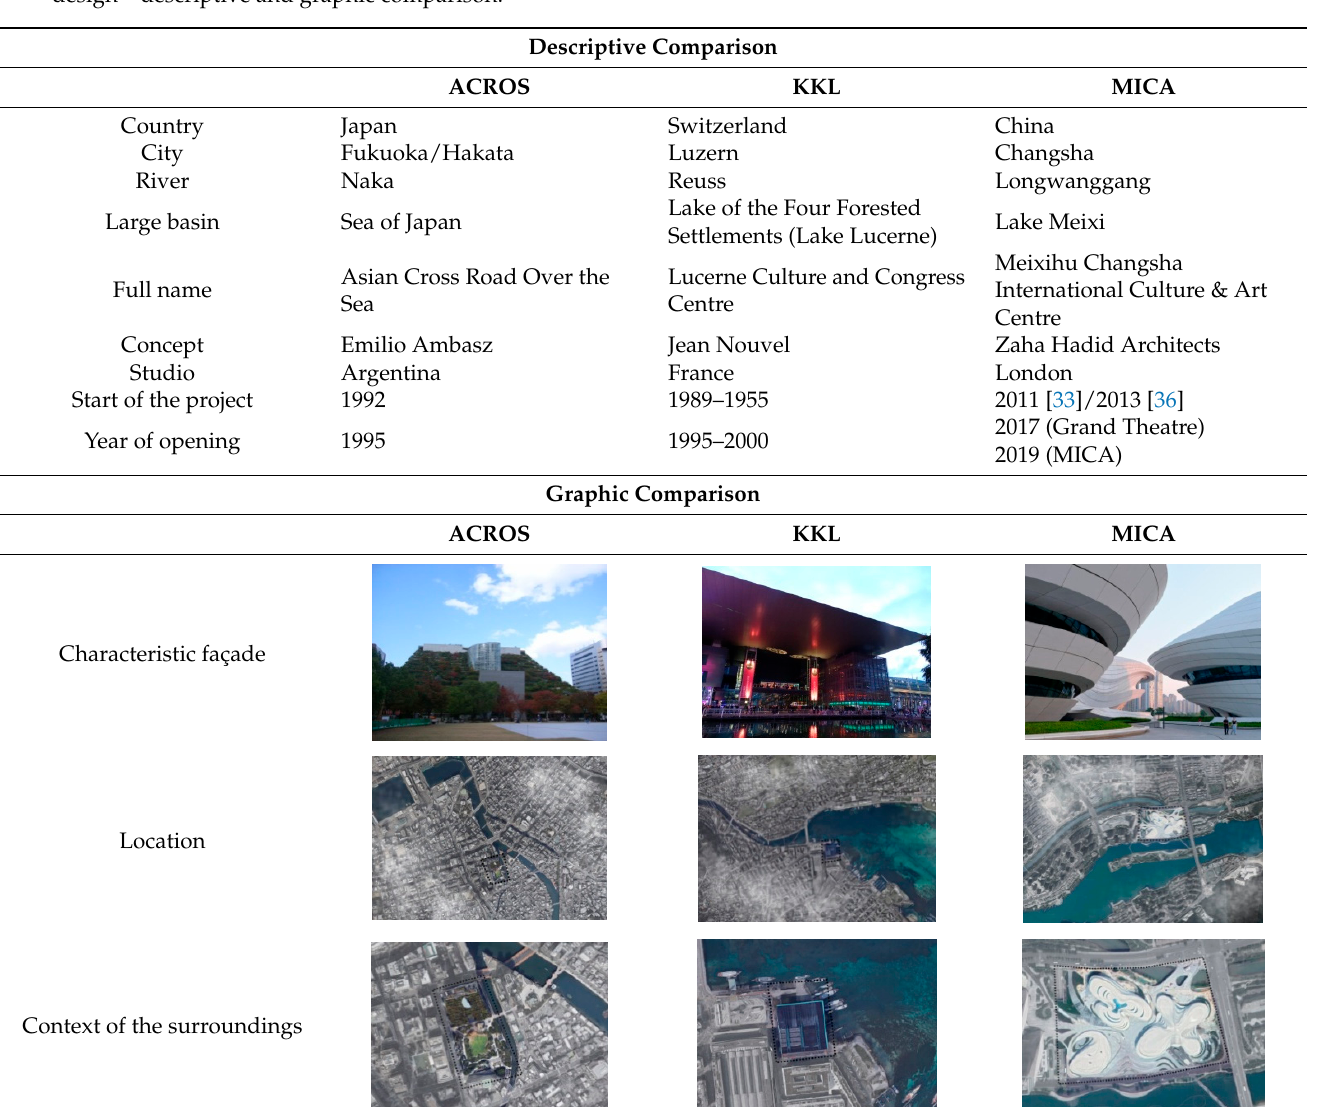
Table 1. Comparison of the bodies of investigated objects: Prefectural International Hall “Asian Cross Road Over the Sea”—ARCOS Fukuoka, Kultur- und Kongresszentrum Luzern—KKL Luzern and Changsha Meixihu International Contemporary Art Museum with the purpose of summarizing the conducted multicriterial case study in the context of intelligence-based design—descriptive and graphic comparison.